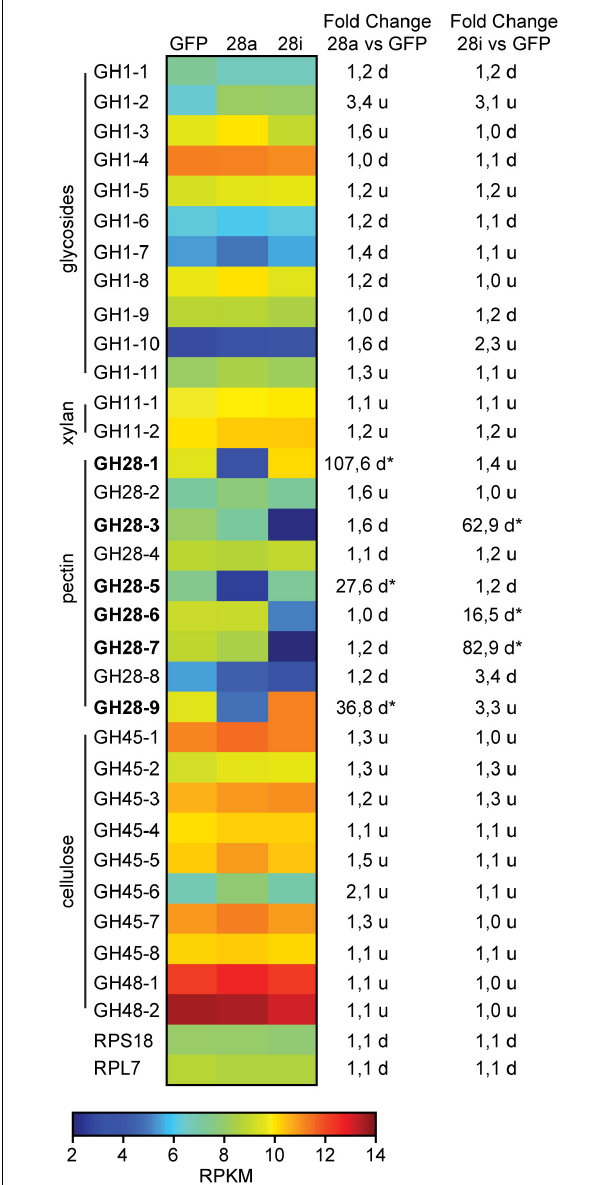
28-1 and 28-9 were higher in 28i than in the GFP